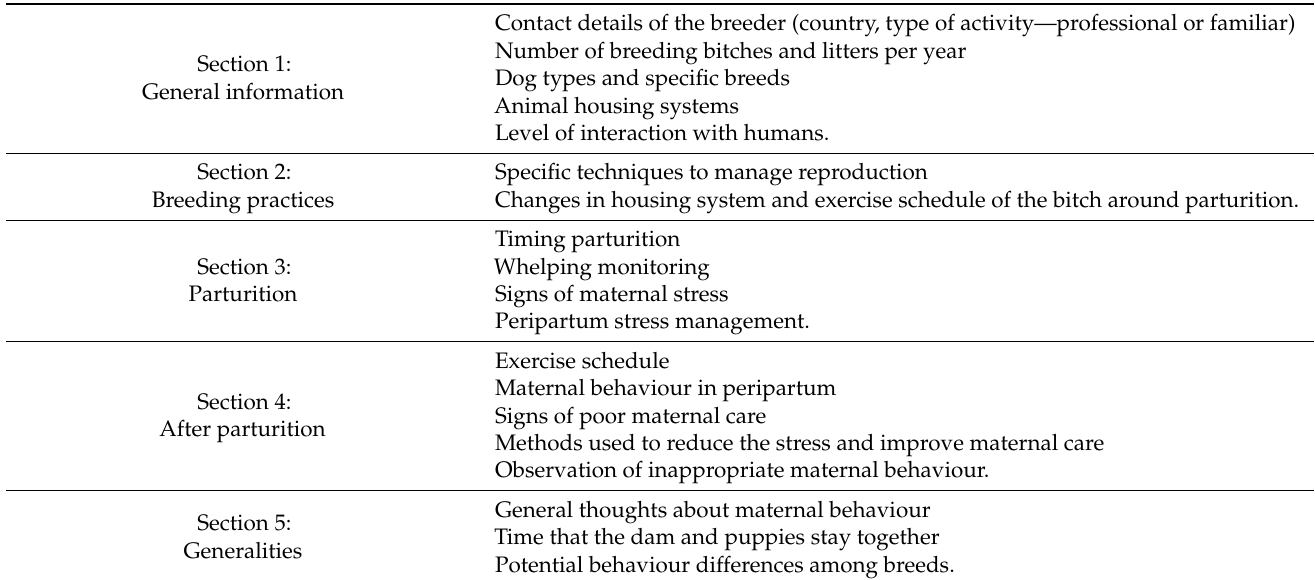
Table 1. Survey structure and main